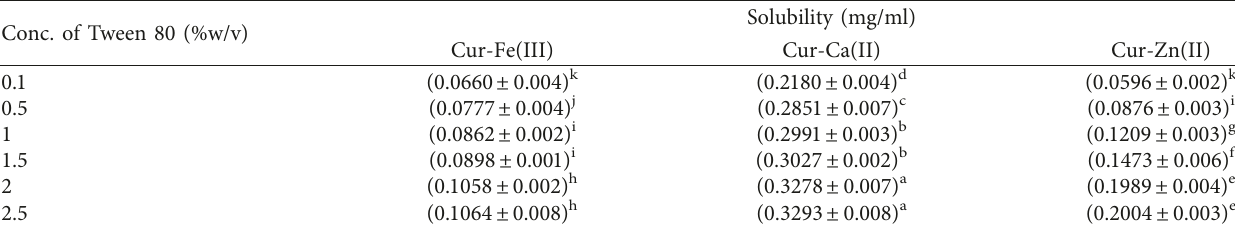
In the same column, different values indicate differences according to the columns ( p < 0 .